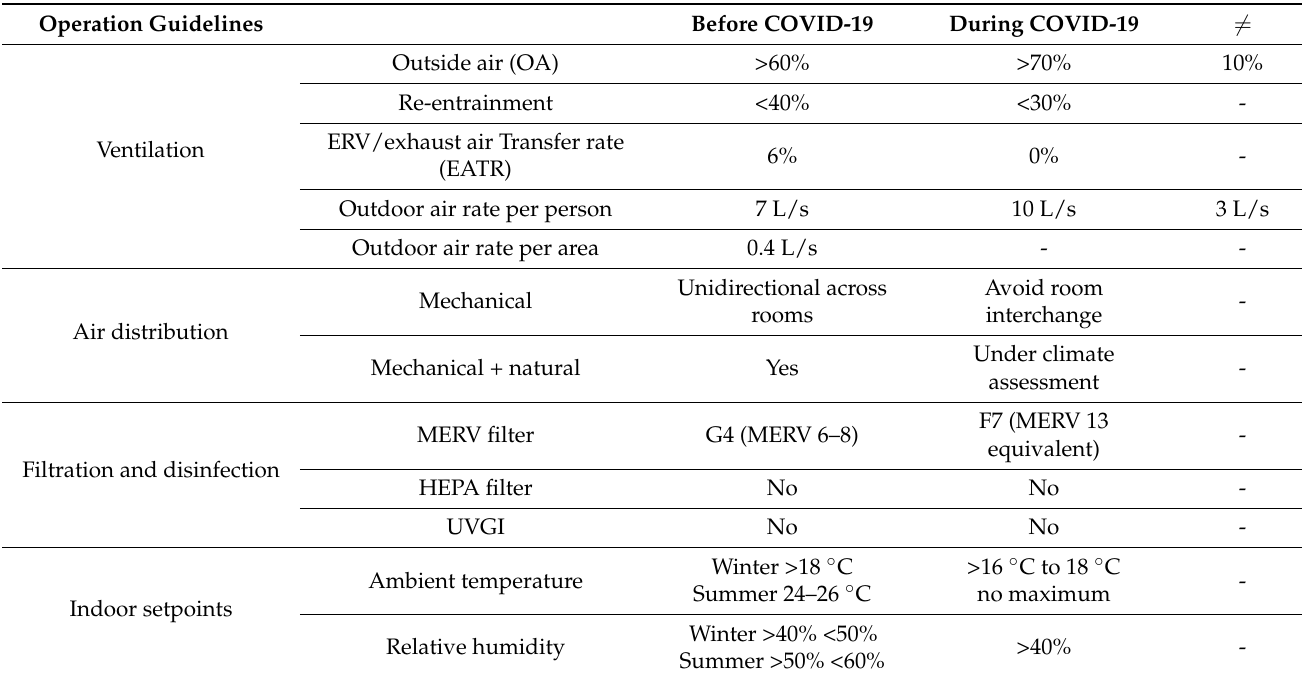
Table 2. CAR guidelines comparison before and during COVID-19